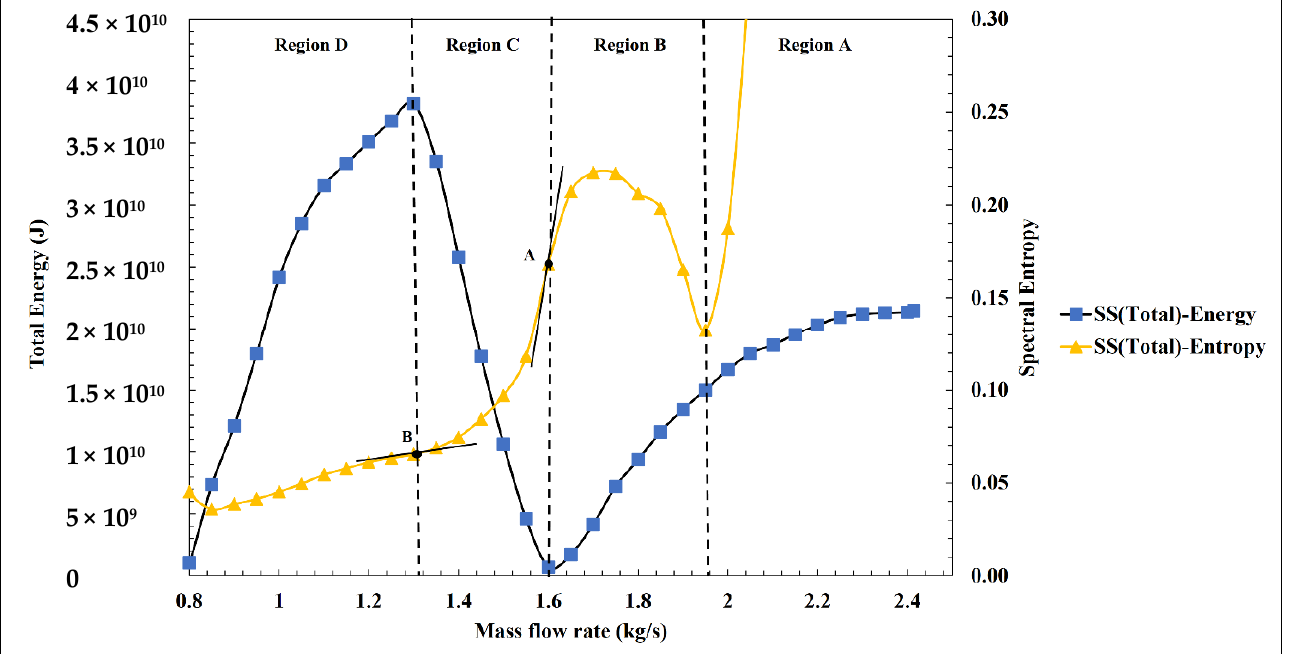
Table 14. Comparison of the stall and surge inception points between predictions and